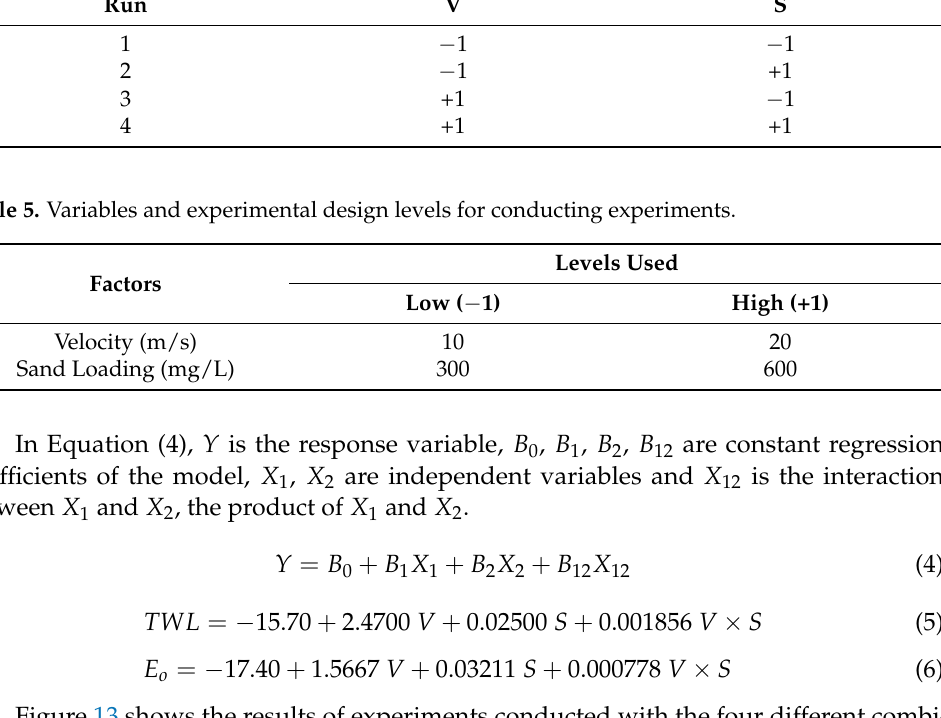
Table 4. Runs for 2 2 experiment design.